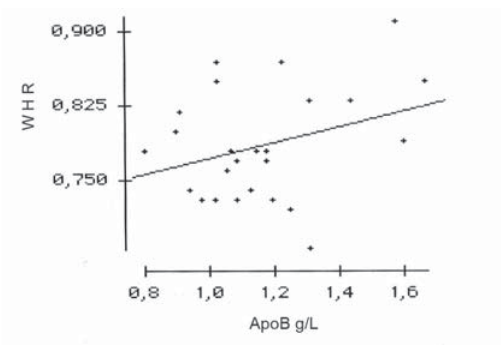
FIGURE 3. Correlation between apolipoprotein B concentra- tion and WHR in post-menopausal